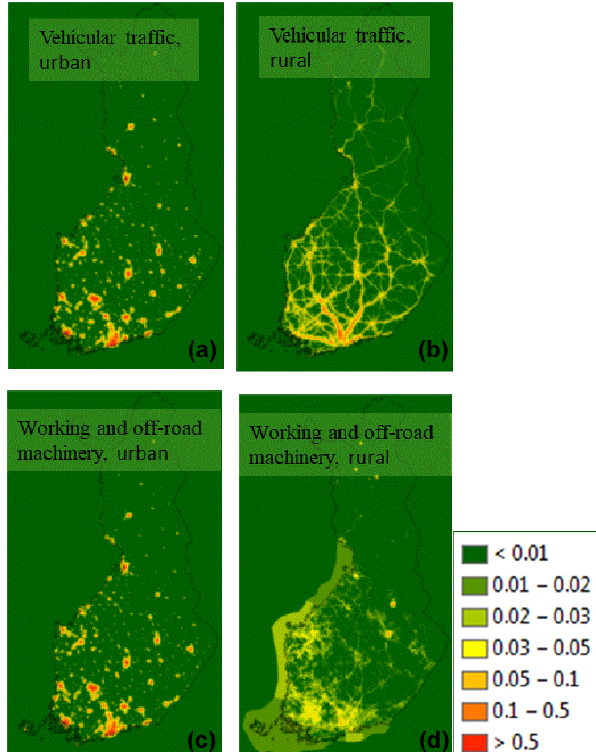
Figure 2. The reductions in concentrations of PM 2 . 5 (ngm − 3 ), caused by a reduction in emissions of PM 2 . 5 by 1t. The results are presented for vehicular traffic (a, b) and working and off-road ma- chinery (c, d) . For both source categories, the changes in urban and non-urban areas are presented separately, in (a, c) and (b, d) , re- spectively. The spatial resolution is 250 × 250m 2